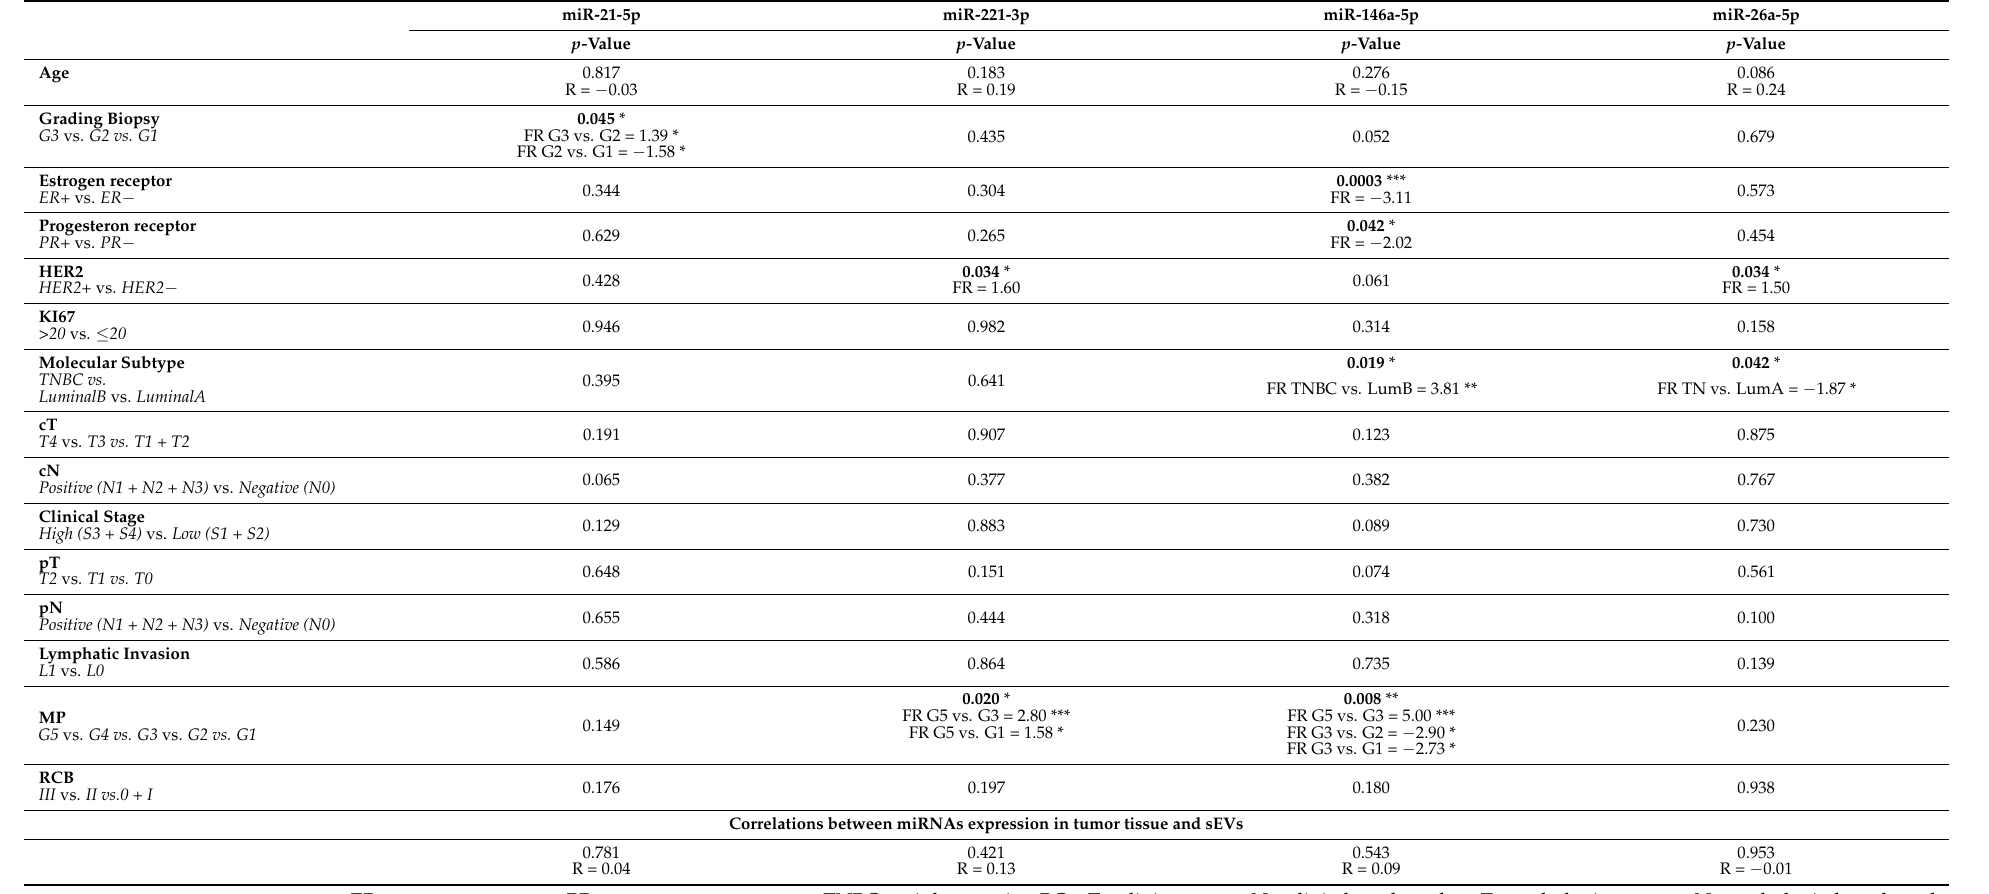
ER—estrogen receptor, PR—progesterone receptor, TNBC—triple negative BC, cT—clinic tumor, cN—clinic lymph node, pT—pathologic tumor, pN—pathologic lymph node, RCB—residual cancer burden, FR—fold regulation. The table shows the p -values for all the compared groups (as indicated in the first column) and where these differences were statistically significant, the expression level of that miRNAs (FR) in the interest group versus the reference group was calculated. According to data distributions, the differences in expression in case of two groups was evaluated with Mann–Whitney test and for three groups with Kruskal–Wallis test, followed by Dunn’s multiple comparison post hoc test. The p -values were highlighted in red when a significant value (<0.05) was obtained, and asterisks indicate the magnitude of p -value (* p < 0.05, ** p < 0.01, *** p < 0.001). In case of three or more groups, the asterisk next to the FR value is associated to the p -value obtained by the Dunn